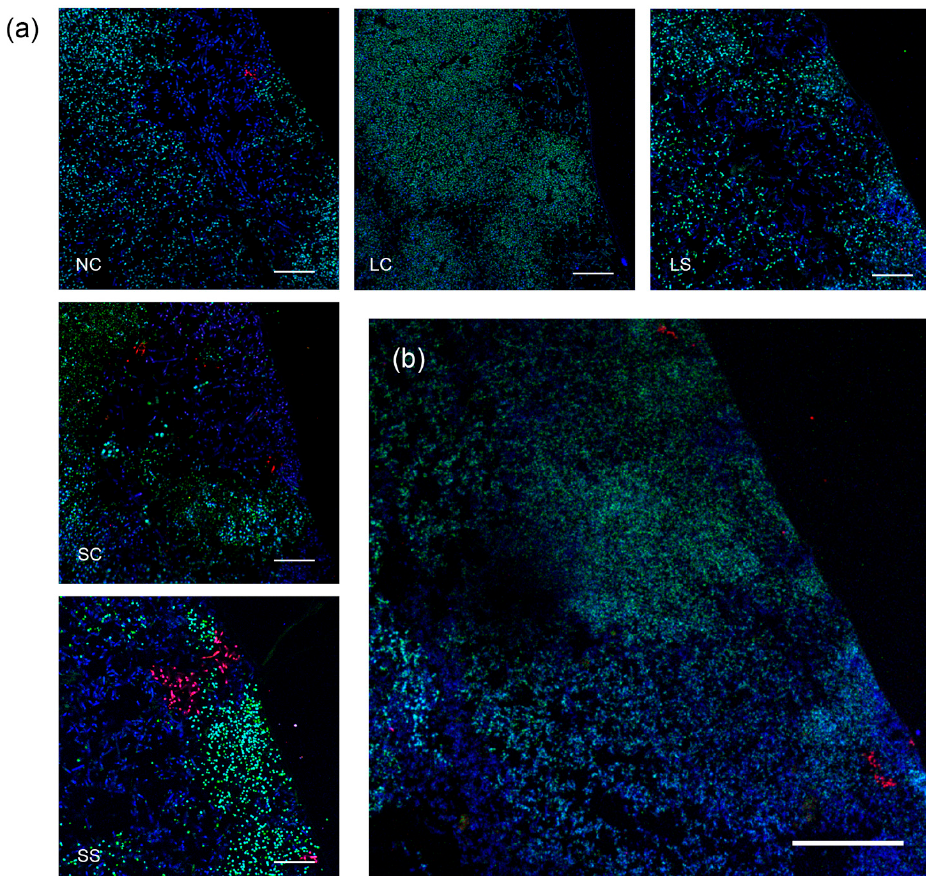
Figure 5. Biofilm architecture, visualized by fluorescence in situ hybridization (FISH). ( a ) In all five treatment groups, compact biofilms were observed, dominated by clusters of streptococci (STR405-Alexa-488, green) and Lactobacillus spp (EUB338-Atto-633, blue). A. naeslundii (ACT476-Atto-550, red) was identified in low numbers in all biofilms, as branched colonies typically located at the biofilm base. Scale bars = 20 μ m. ( b ) Representative image (from LS group) demonstrates the complex biofilm architecture with cell clusters, cell-free areas, and a bulged surface, which resemble the structure of supragingival biofilm. No significant structural modification was observed between experimental groups. Scale bar = 60 μ m. Dark areas represent the enamel surface of the specimens. LC: L. reuteri whole culture; LS: L. reuteri culture supernatant; SC: S. oligofermentans whole culture; SS: S. oligofermentans culture supernatant; NC: negative medium control.